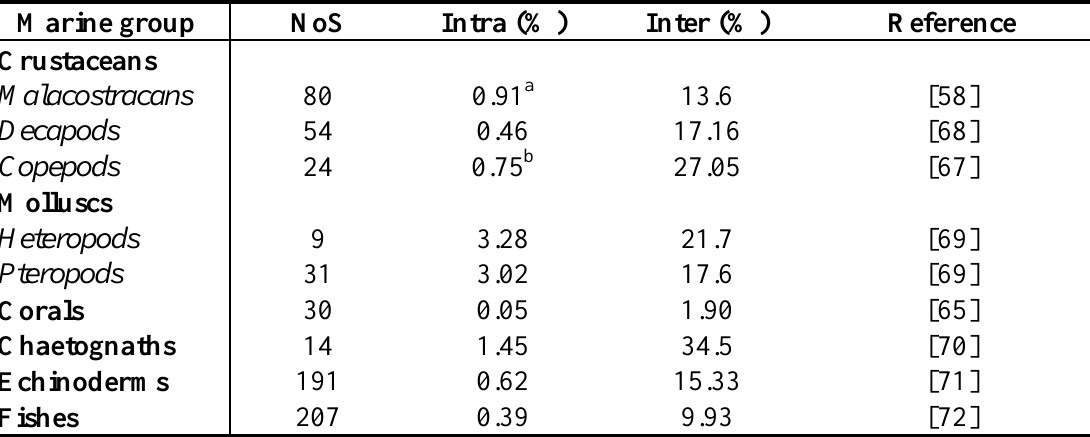
Table 2. Levels of genetic divergence in marine taxa. Only studies using the 5’ end of COI and giving average K2P genetic divergences were included. NoS: number of species barcoded; Intra: mean genetic distances within species; Inter: mean genetic distances between